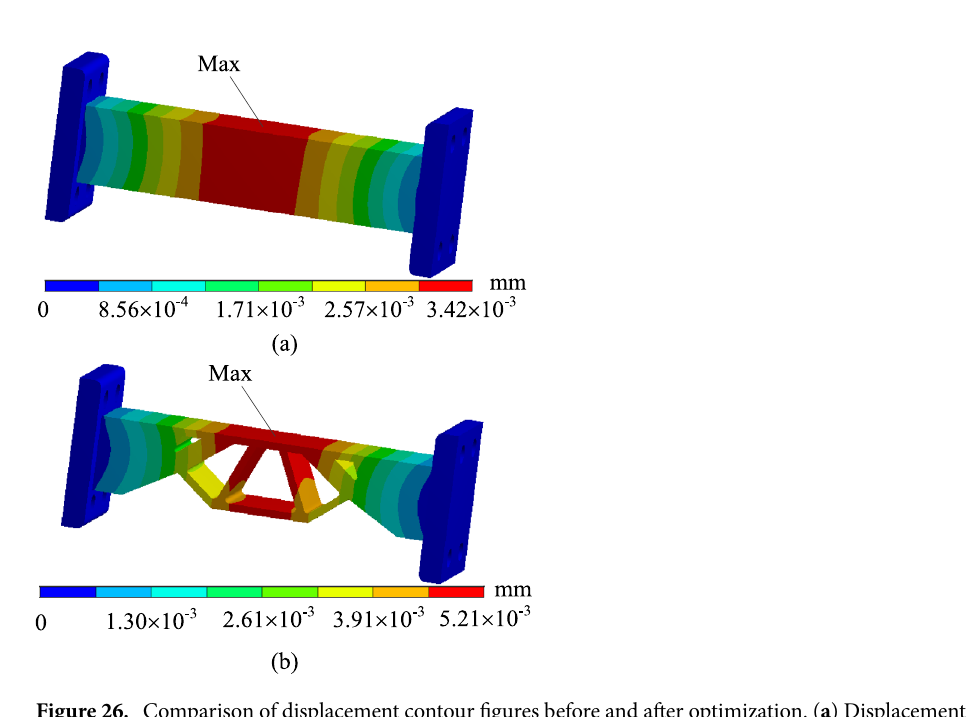
Figure 25. Comparison of stress contour figures before and after optimization. ( a ) Stress contour figure of the original model ( b ) Stress contour figure of the reconstructed model.